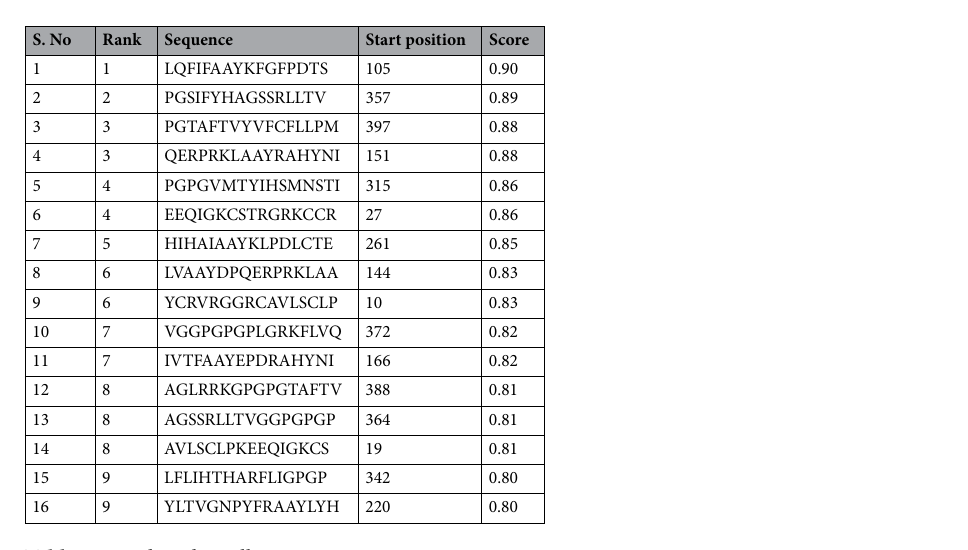
Table 7. Predicted B cell epitopes in vaccine construct.